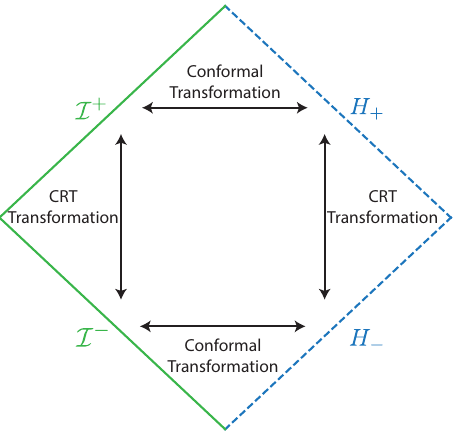
Figure 5 . Diagram showing the transformations that map between the four boundaries of the extremal black hole (6.1): I ± and H ± . The mapping of the charges under the conformal and CRT transformations where explored on the first two subsections of section